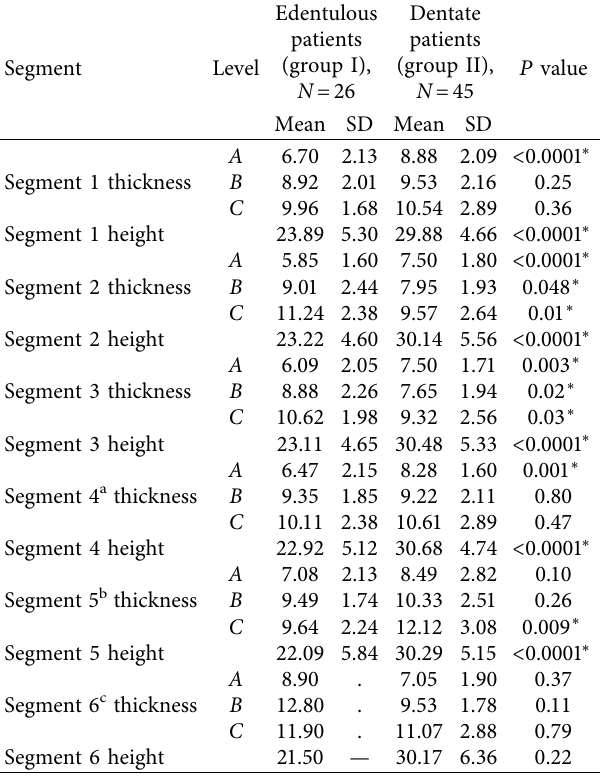
Table 1: Difference between dentate and edentulous patients in mandibular height in mm and mandibular thickness at various